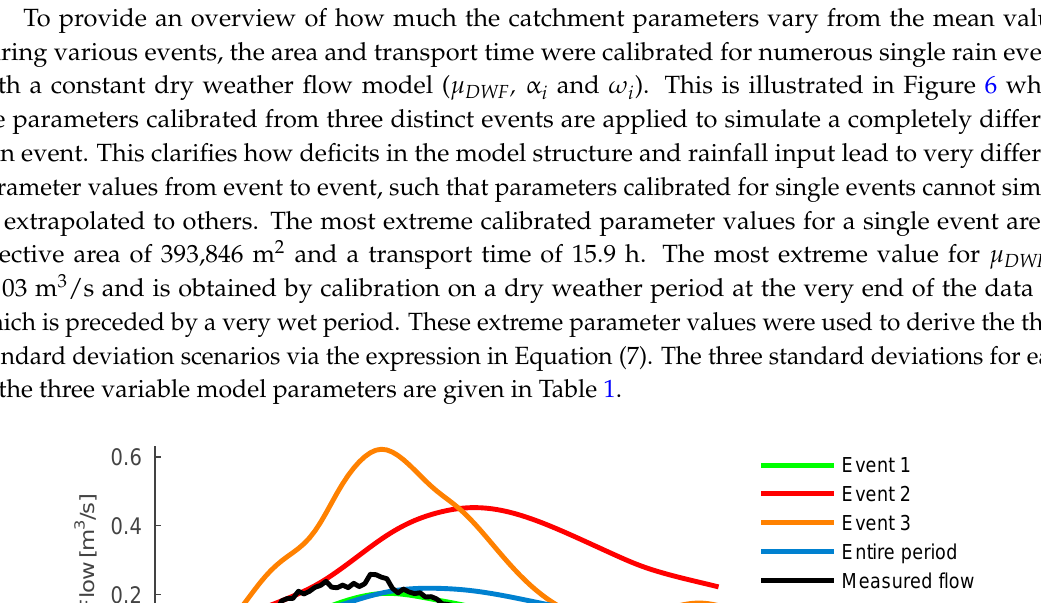
Figure 7. Forecast performance for different σ‐ scenarios with a fixed length of the auto ‐ calibration period; ( a ) 8 h; ( b ) 12 h; ( c ) 16 h. Generally, forecast performance decreases as the forecast horizon increases for all combinations of (cid:2026) ‐ scenarios and auto ‐ calibrations periods. This happens because the model parameters are calibrated to present conditions, which become less representative the further into the future a forecast is made. The least constrained parameter scenario, σ (cid:2869)⋅(cid:2889)(cid:2934)(cid:2930)(cid:2928)(cid:2915)(cid:2923)(cid:2915) , produces the best forecasts for